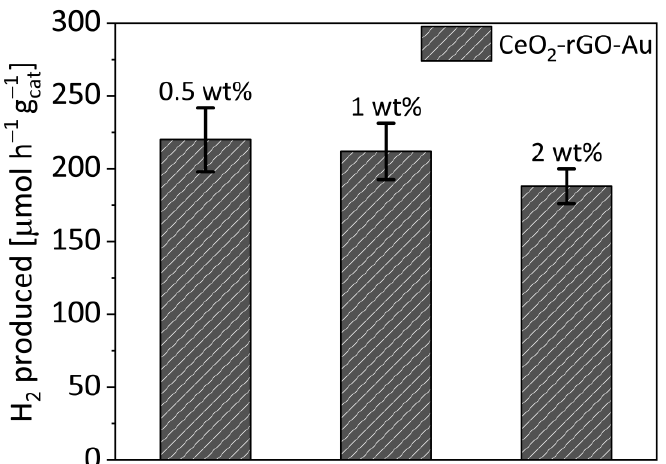
Figure 1. H 2 evolution considering the different rGO content on CeO 2 -based samples. All the samples contain gold at 1 wt% as co-catalyst.